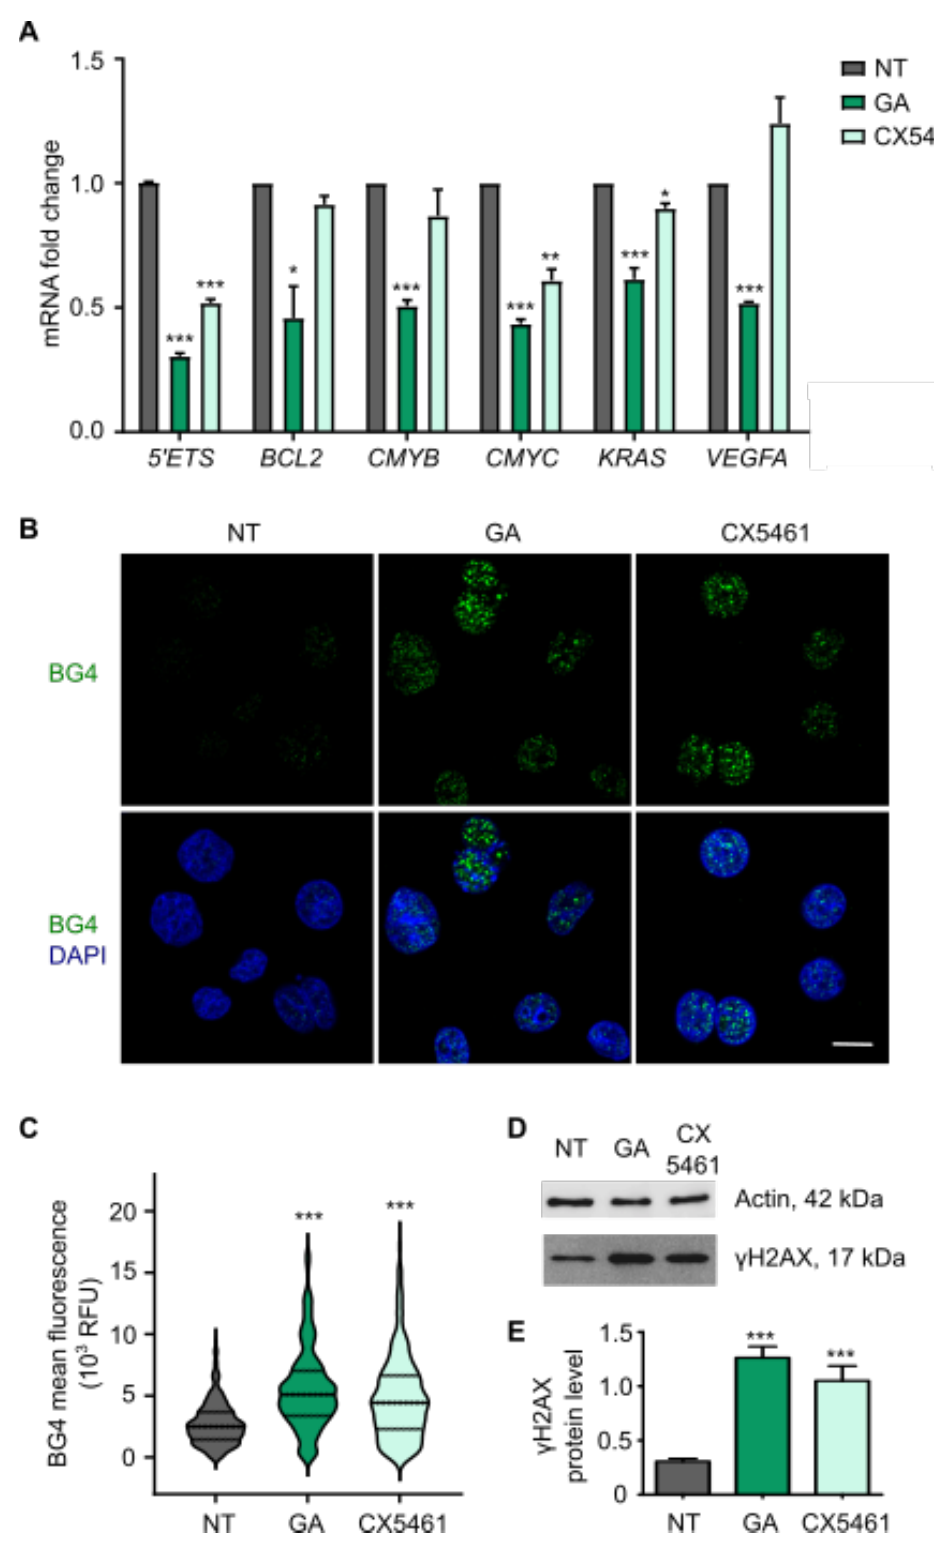
Figure 2. Gallic acid stabilizes G4s inhibiting the transcription of several oncogenes and inducing DNA damage.( A ) SW480 cells were treated with vehicle DMSO (NT), GA IC 50 or CX5461 10 µM for 6 h and transcription of different G4-enriched genes was analyzed by qRT-PCR. Columns represent mean ± standard deviation. ( B ) Immunofluorescence images of SW480 cells treated with vehicle (NT), GA IC 50 or CX5461 10 µM for 6 h and stained with the G4-selective antibody, BG4. Merged images with DAPI for DNA counterstaining are also shown. Scale bar, 10 µm. ( C ) Quantification of nuclear BG4 mean fluorescence intensity by Fiji analysis from cells in ( B ) (N > 250). ( D ) Western